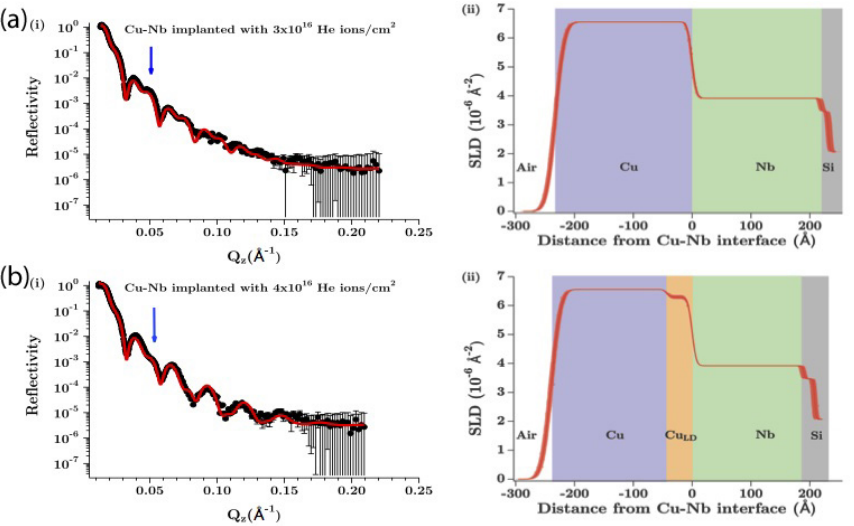
Figure 4. Reflectivity curves ( left column) and SLD profiles ( right column) for ( a ) 3 × 10 16 /cm 2 and ( b ) 3 × 10 16 /cm 2 He ions implanted in a Cu/Nb bilayer on a Si substrate. Reprinted with permission from Reference [42]. Copyright (2013), AIP publishing LLC.